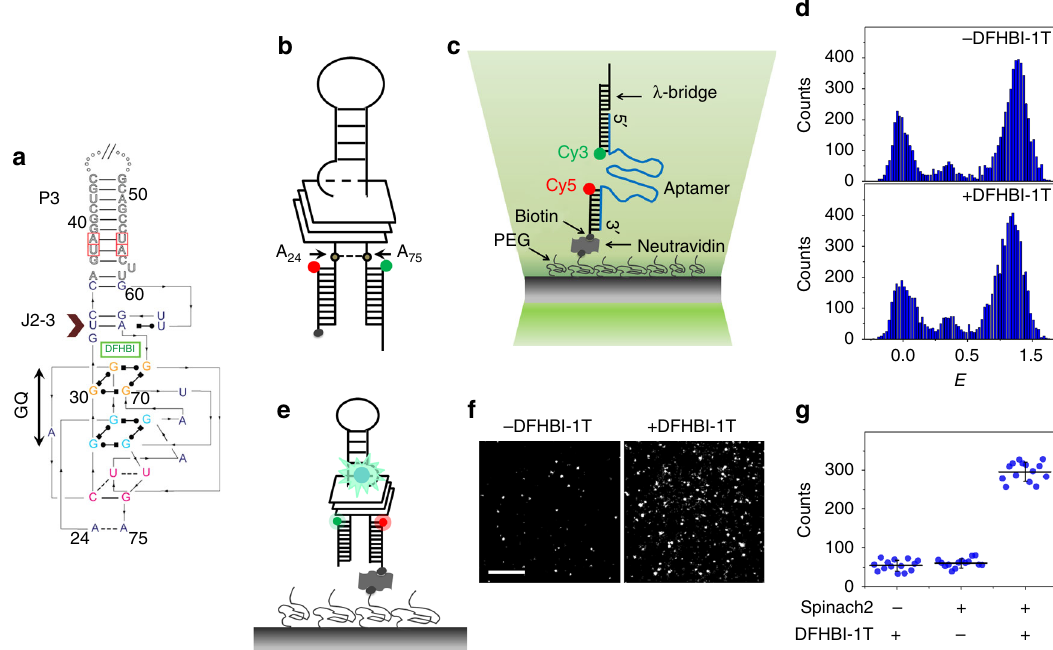
Fig. 1 Conformational analysis of a Spinach2 aptamer. a Sequence and secondary structure of Spinach2-DFHBI used in this study 17 . Adapted with permission from ref. 17 . The Spinach2 GQ, fl anking duplex stem, P3, and the base-triple junction J2-3 are indicated in the fi gure. b A schematic of Spinach2 construct used in our studies. The nucleotides are numbered with respect to the Spinach2 crystal structure 17 . The FRET pair of dyes, Cy5 (red) and Cy3 (green) are located adjacent to A 24 and A 75 of Spinach2, respectively. Biotinylation of the Cy5-labeled oligo is represented by a black sphere. c A schematic representation of the smFRET assay. The RNA aptamer (Spinach2, in this fi gure) was annealed to Cy3 (donor) and Cy5 (acceptor) labeled handles on the 5 ′ and 3 ′ sides, respectively. The Cy5-labeled oligo is biotinylated at the 5 ′ end. The construct is immobilized on the PEG-passivated surface via neutravidin – biotin interaction. FRET was measured between Cy3 and Cy5. The Cy3-labeled handle is further annealed to 30 nt long λ -bridge for use in fl uorescence-force measurements. FRET was measured between Cy3 and Cy5. d E histograms of Spinach2 in a buffer supplemented with 100 mM K + and 5 mM Mg 2 + , in the absence (top) and presence (bottom) of DFHBI-1T. e Schematic representation of DFHBI-1T (blue sphere) bound Spinach2 on a single- molecule platform. f The fl uorogenic module elicits GFP-like fl uorescence on excitation with 488 nm laser. (Scale bar: 5 μ m). g Average number of fl uorescent spots per image area before and after 30 min incubation with 5 μ M DFHBI-1T. Source data are provided as a Source Data